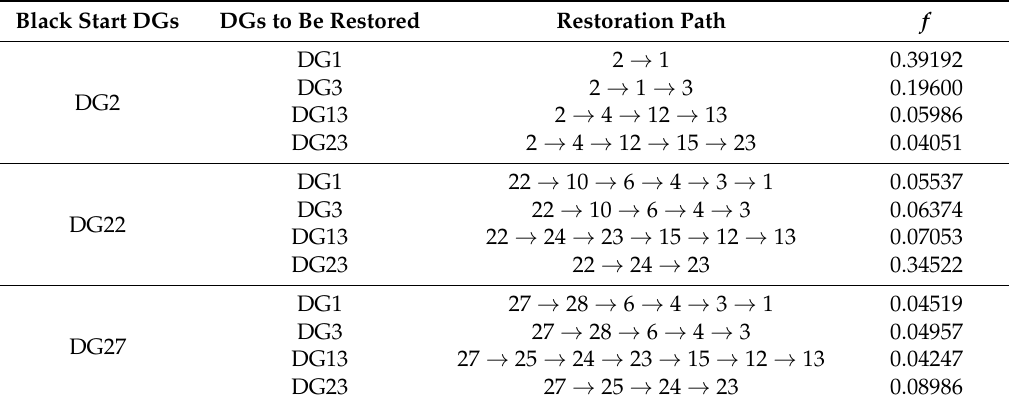
Table 6. The restoration path with maximum f